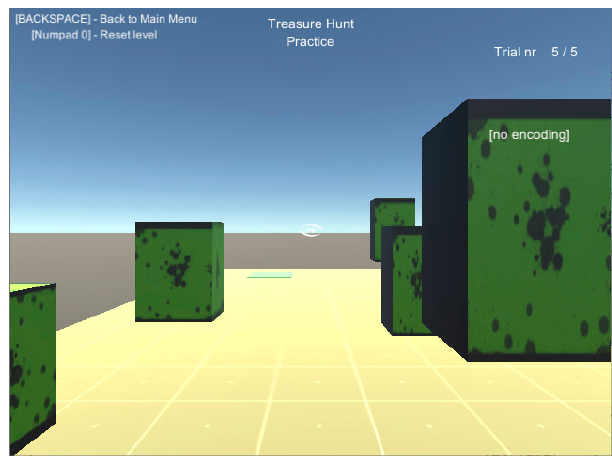
Figure 2. The system architecture for the real-world (RW) setup. PPG-plethysmography.